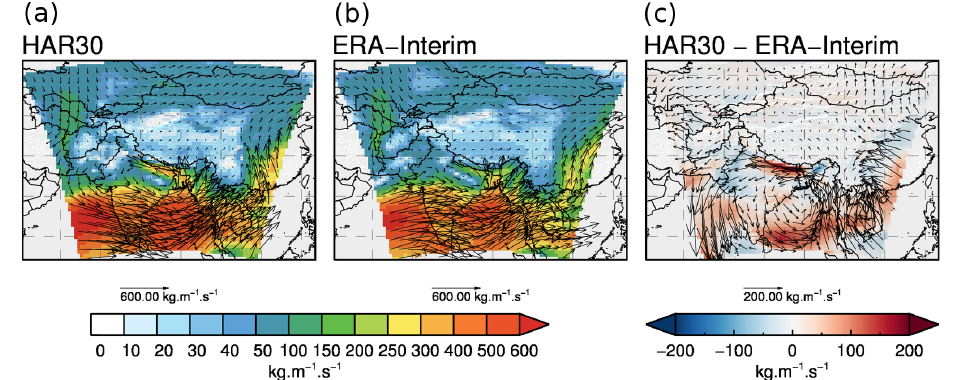
Figure 2. Decadal average of the vertically integrated water vapour flux (kgm − 1 s − 1 ) in July for HAR30 (a) , ERA-Interim (b) and their difference (c) . The grid points without HAR30 data are masked out. Colour shading denotes strength of water vapour flux, arrows (plotted every second grid point) indicate transport direction (length of arrows is proportional to flux strength up to 600kgm − 1 s − 1 for (a) and (b) and up to 200kg m − 1 s − 1 for (c) and is constant afterwards for more readability).